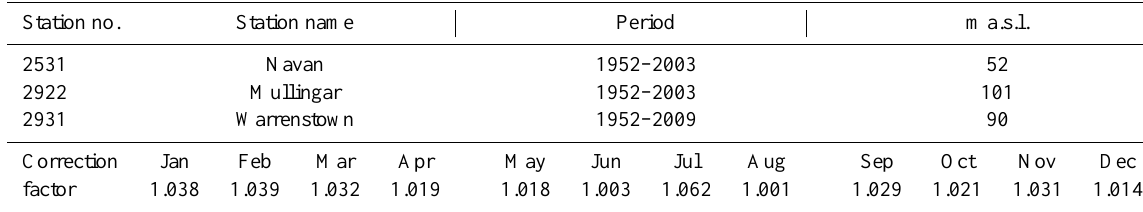
Table 2. Stations and correction factors used to obtain catchment average precipitation. Station